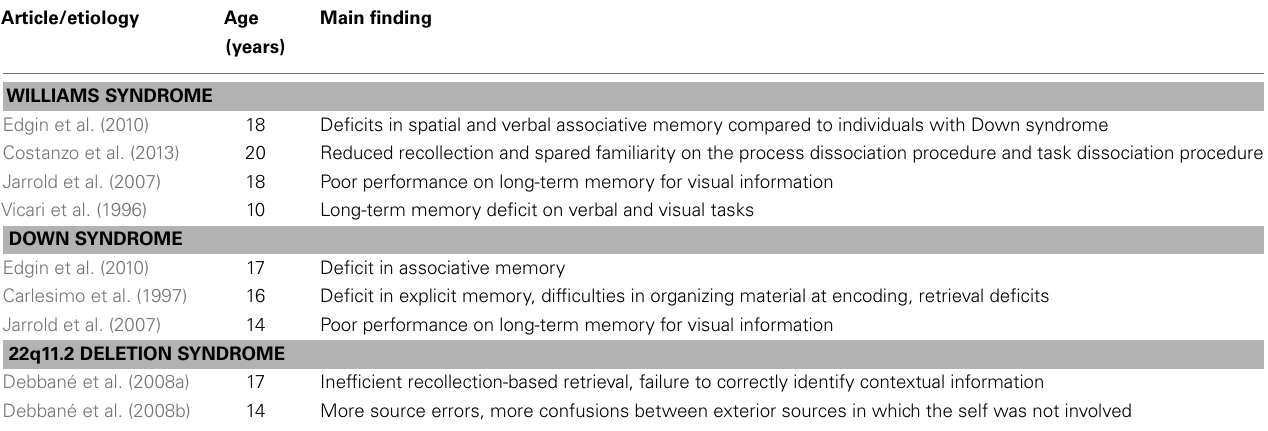
Table 3 | Key findings on episodic memory and metamemory in children and adolescents with genetic disorders